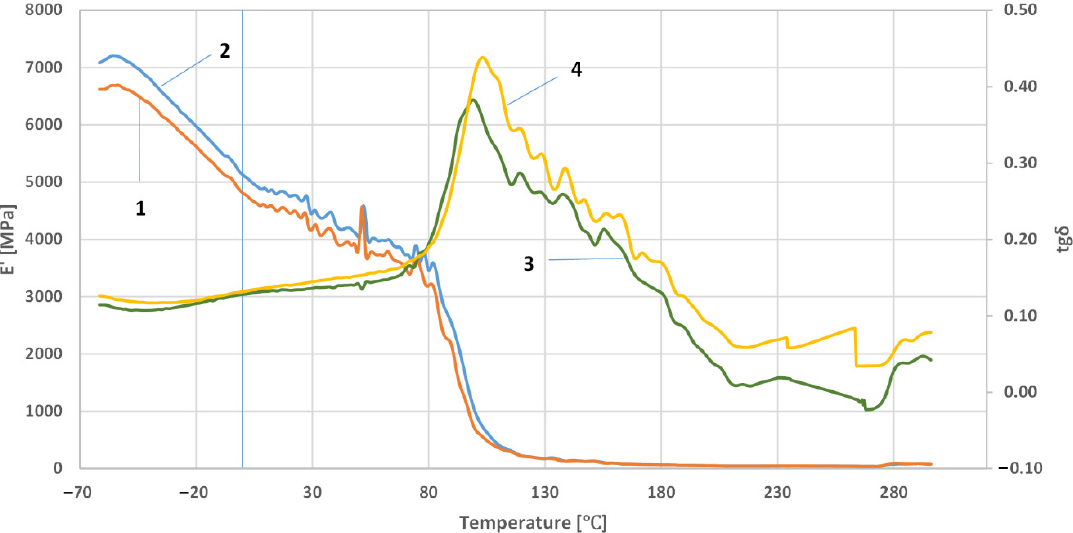
Figure 6. The dependence of the conservative modulus and the tangent of the mechanical loss angle on the temperature of the composite of resin with aluminum chips: at a frequency of 1 Hz—1, 3; at a frequency of 10 Hz—2, 4.